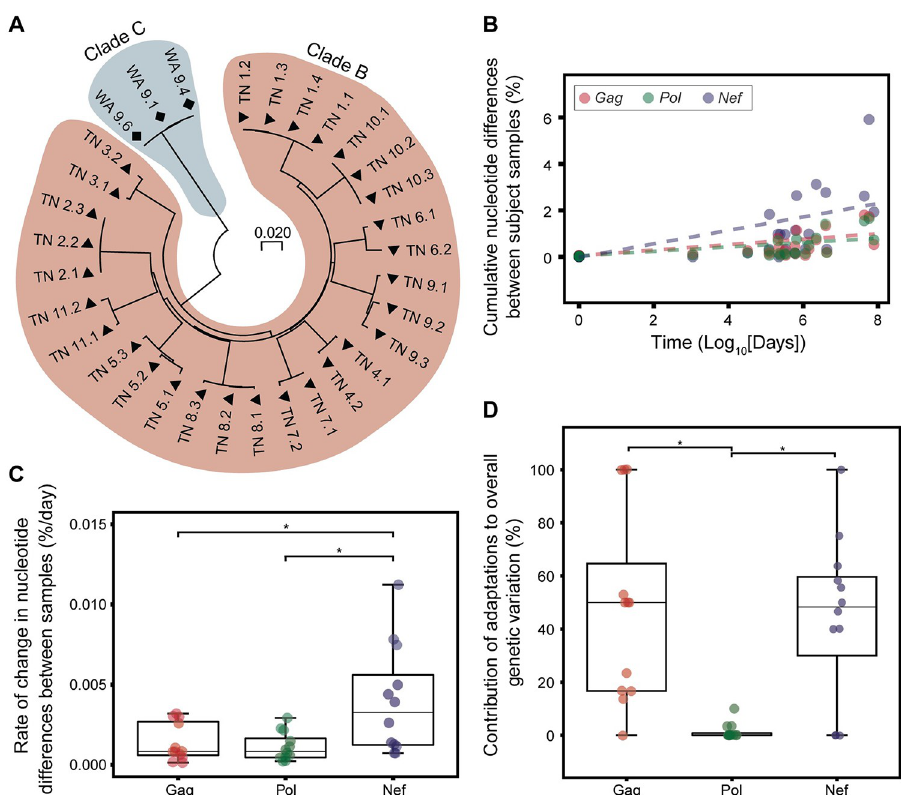
Fig 2. The HIV proteome, particularly Nef, exhibits significant nucleotide variability over time. A) Evolutionary analysis of Gag, Pol and Nef majority sequences illustrates clade and longitudinal sample clustering. Phylogenetic tree constructed using the Maximum Likelihood method with the Hasegawa-Kishino-Yano model. B) Nucleotide variation in Gag, Pol and Nef all exhibit a significant positive correlation with time ( p < 0.001 for all three proteins; mixed effects linear regression model). C) Nef demonstrates the greatest variation at the nucleotide level compared to Gag ( � , p = 0.032) and Pol ( � , p = 0.021), as measured using rate of change per day. D) Viral adaptations contribute significantly to the genetic variation in Gag ( � , p = 0.022) and Nef ( � , p = 0.036), compared to Pol. Analyses in (C) and (D) using Friedman test and Holm-corrected Wilcoxon